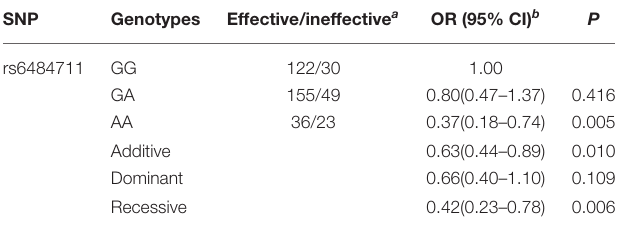
TABLE 4 | Association analyses between rs6484711 and therapeutic effect of neoadjuvant chemotherapy in the combined